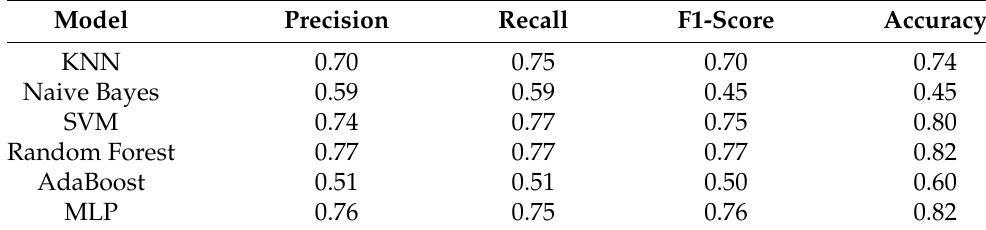
Table 9. Classification Results Embeddings Titles.